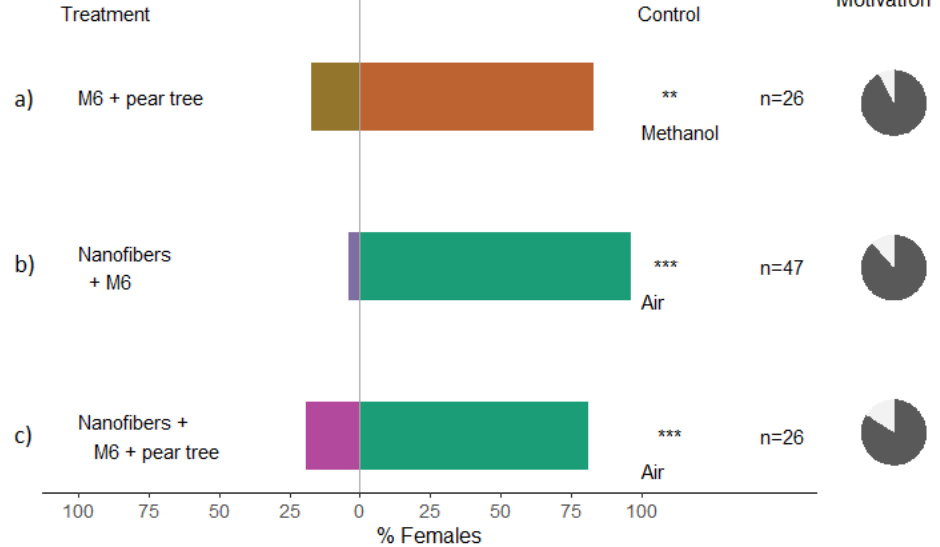
Figure 4. Results of Y-olfactometer-bioassays testing synthetic clove VOCs with adults of Cacopsylla pyri to establish whether they are repellent and could mask the odors of the host Pyrus communis cv. Williams Christ plants. ( a ) M6 (5% concentration in methanol) and a potted pear tree against methanol as control; ( b ) Nanofibers formulated with M6 (5% v / v ) against air; ( c ) Nanofibers formulated with M6 (5% v / v ) and a potted pear tree against air. The letter “n” corresponds to the numbers of insects used for the tests. Results are shown as the percentage of psyllids in each arm. Statistically significant differences are indicated with ** ( p < 0.01); *** ( p < 0.001). Percentage of psyllids that made a choice (dark gray) or not (light gray) is presented as pie charts on the right.